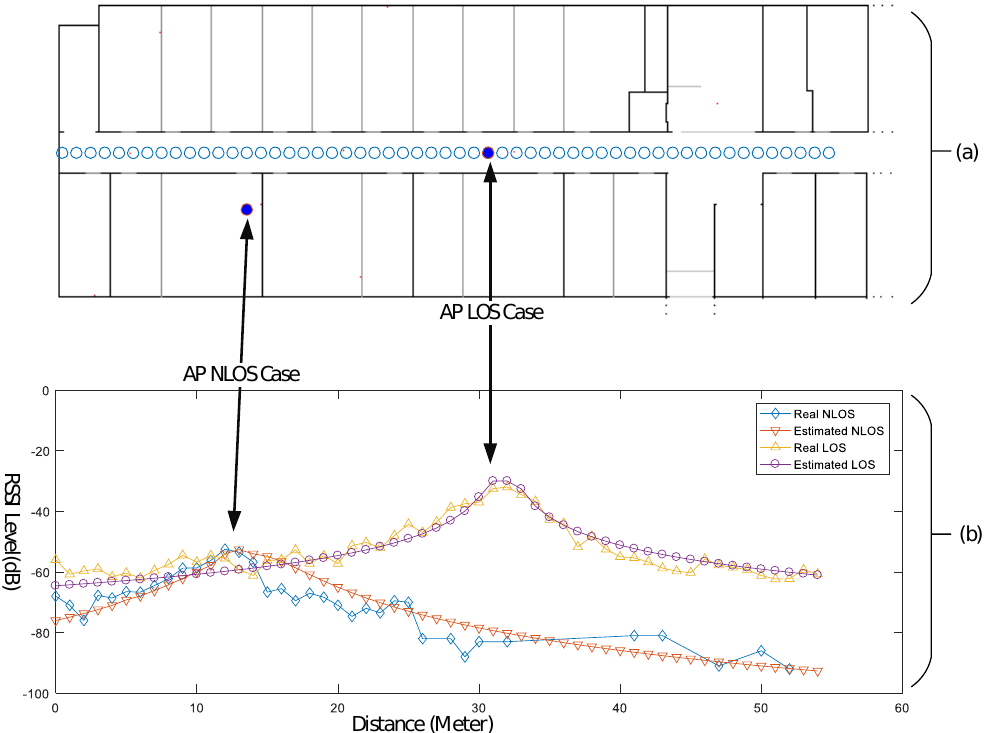
Figure 4. ( a ) reference points to measure actual RSSI level received by a handheld device inside an office environment (IT Building) and ( b ) real and estimated RSSI with respect to distance for both LOS AP and NLOS AP